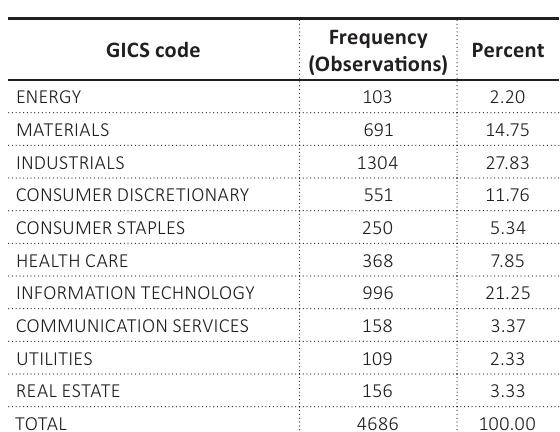
Table 1. Distribution of